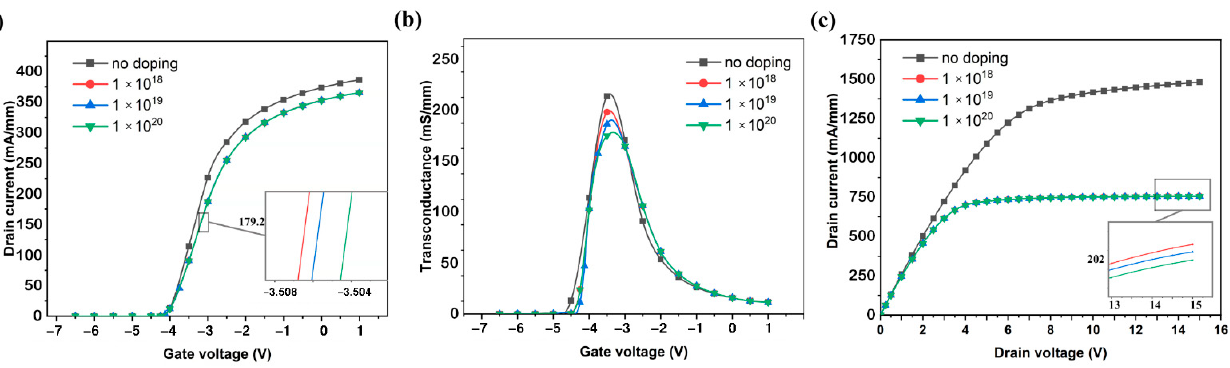
Figure 8. ( a ) Transfer characteristics, ( b ) transconductance, and ( c ) output characteristics of the HEMT of AlGaN buffer layer with different doping concentrations.